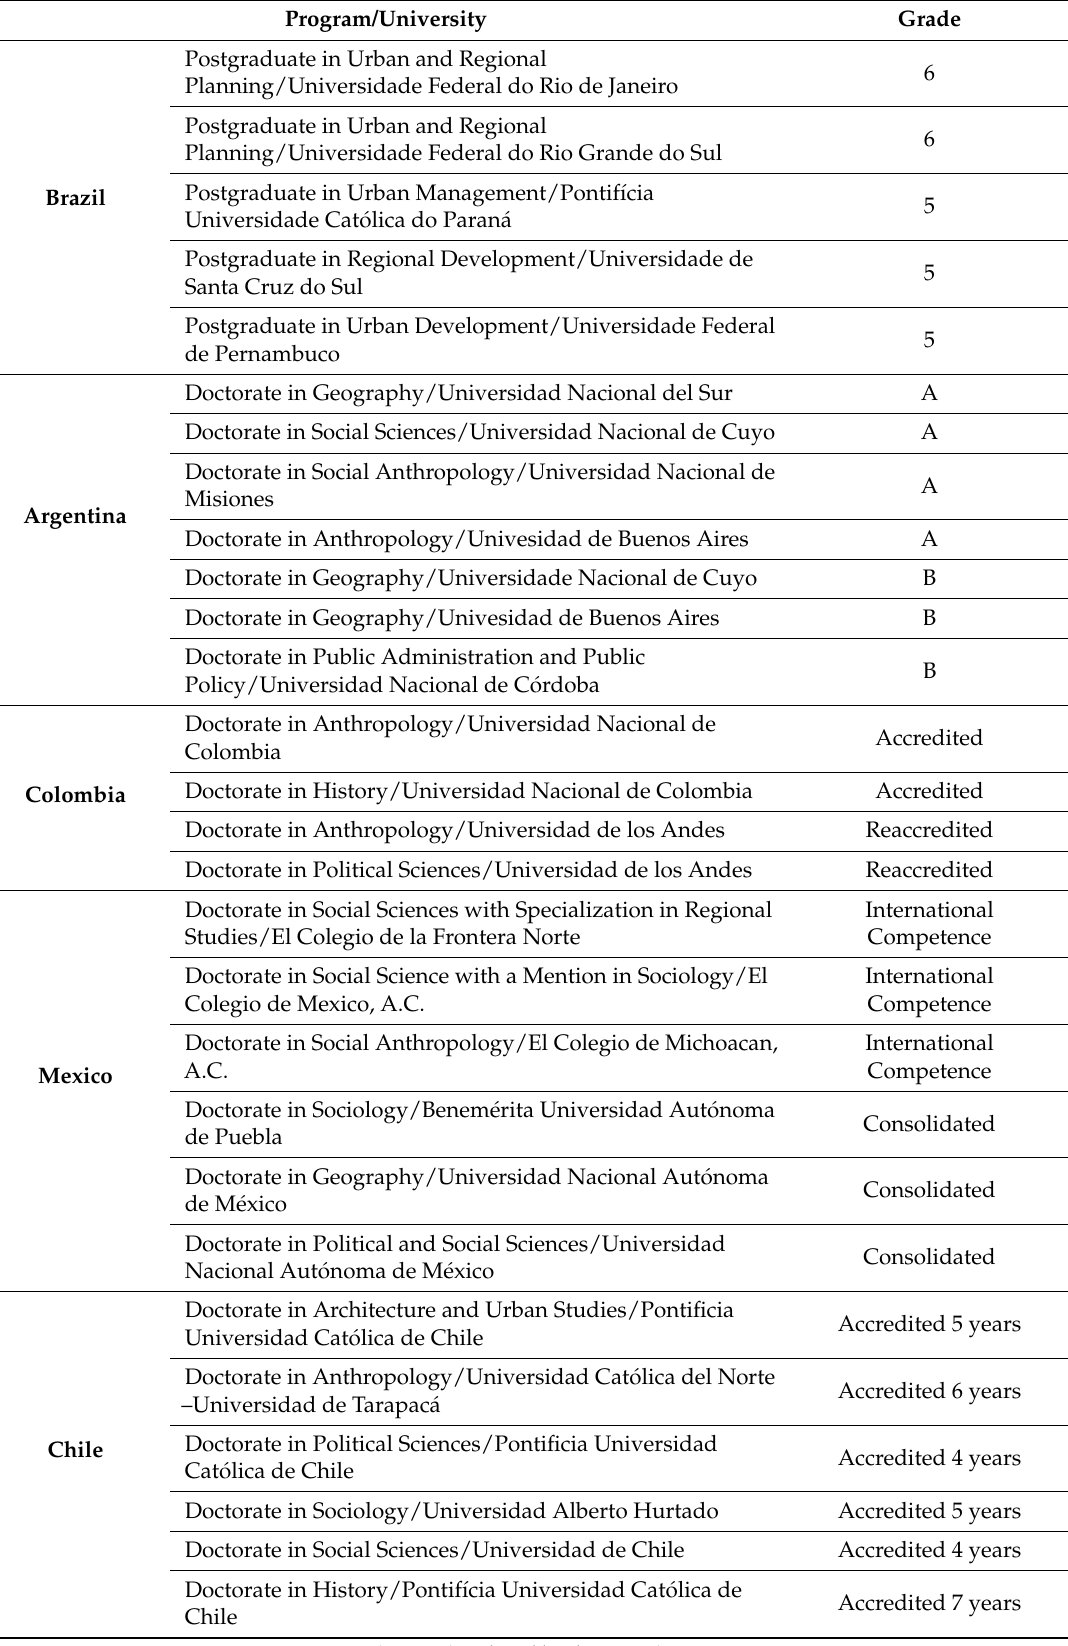
Table 3. Selection of post-graduation program in urban and regional planning/cities in selected countries of Latin